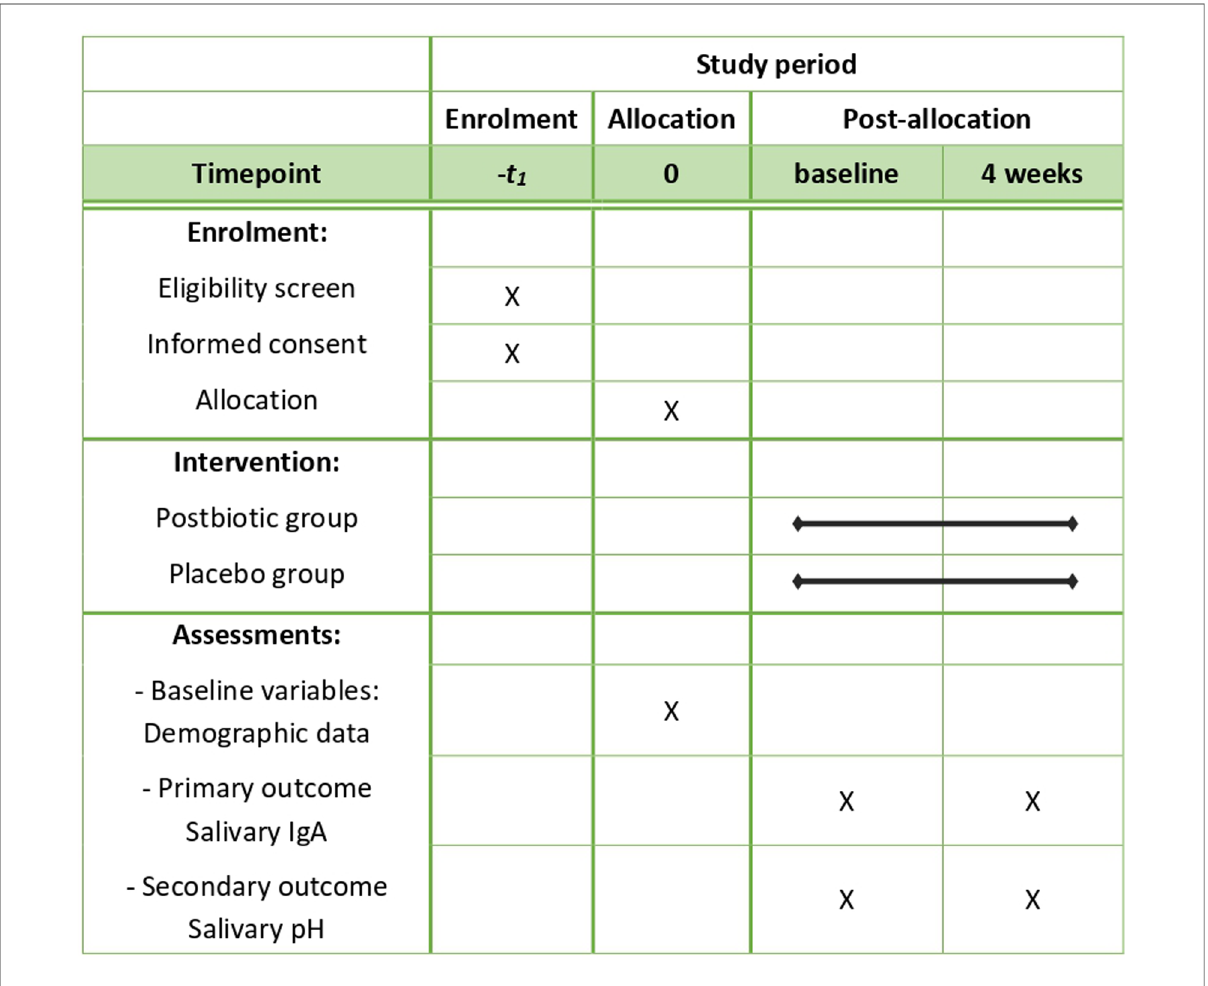
FIGURE 2 Schedule of enrolment, intervention, and assessments. IgA, Immunoglobin